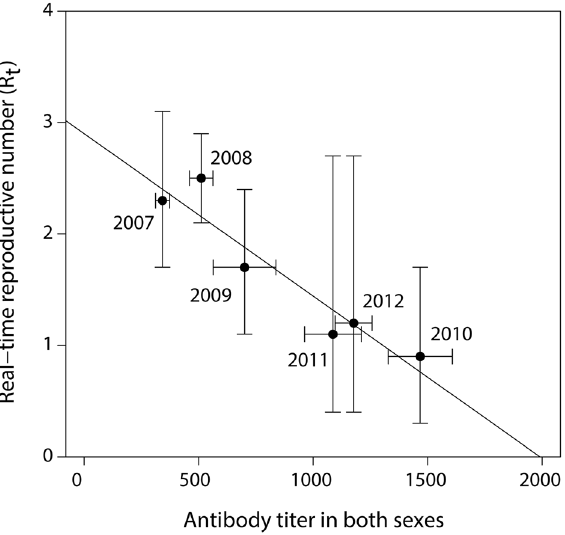
Figure 3. Association between the annual real-time reproductive number (R t ) (± 95% c.i.) and annual average antibody titer (± s.e.m.) of both sexes of apparently healthy Northern common eiders upon arrival at Mitivik Island, from 2007 to